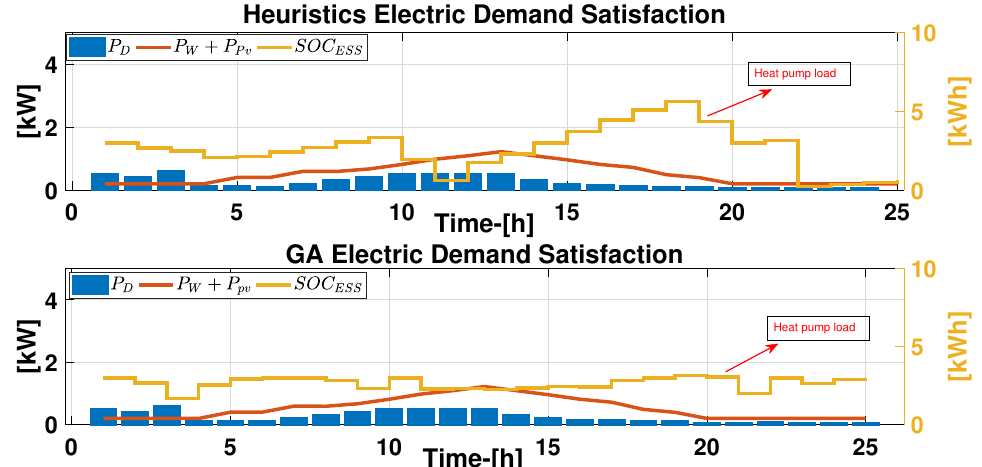
Figure 9. Heuristics and GA electric demand satisfaction numerical results.